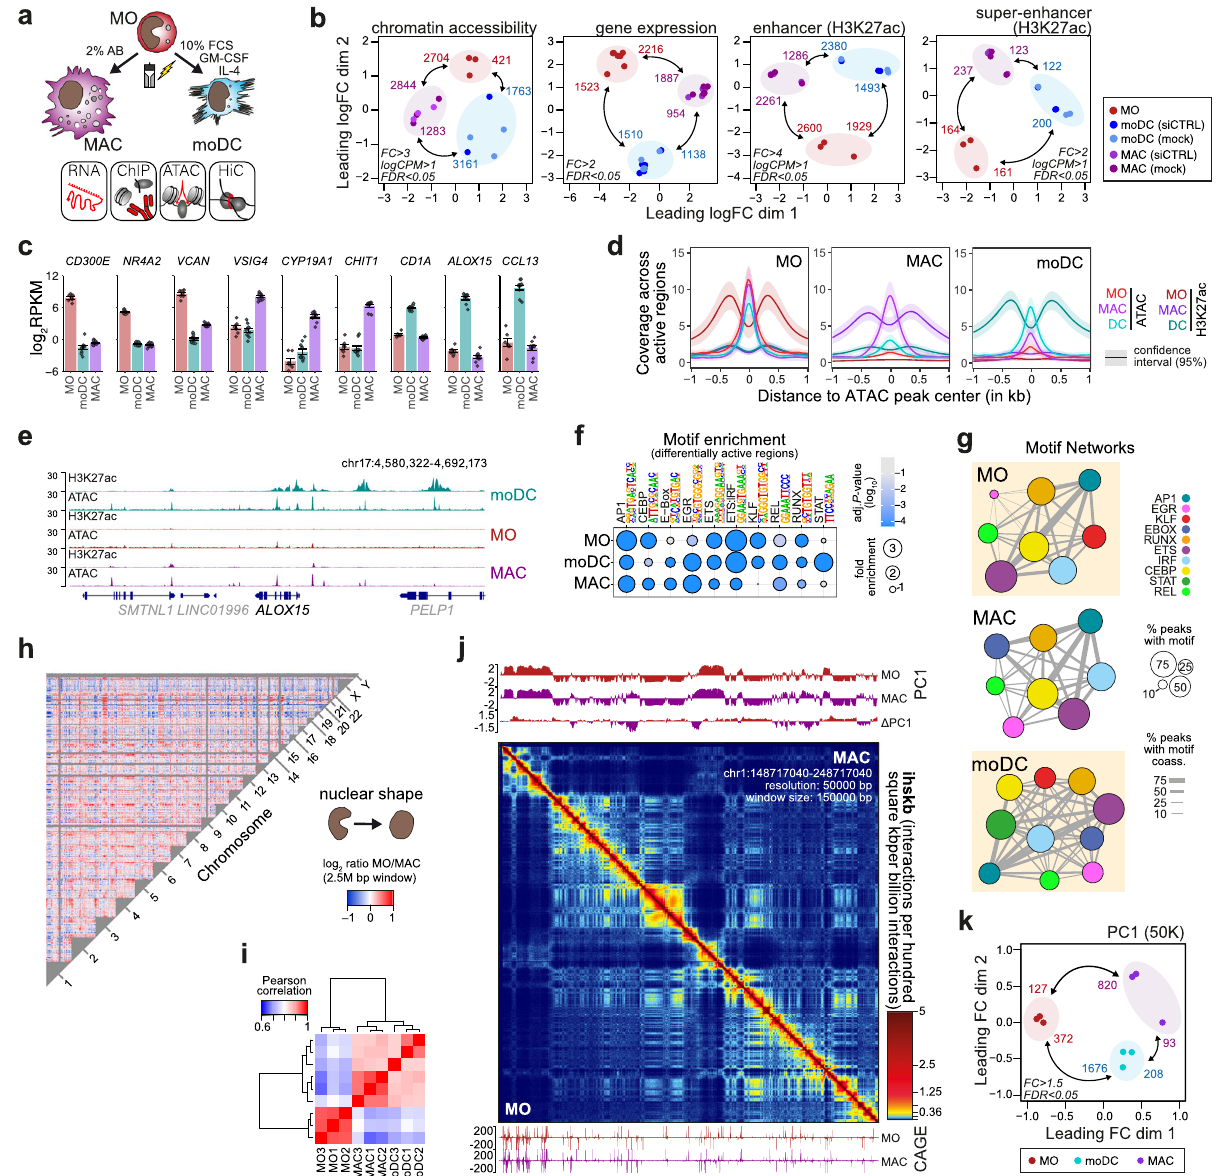
Fig. 1 Epigenetic, transcriptional and architectural changes during MO differentiation. a Schematic of the experimental setup. Since cells served as controls for the siRNA-mediated knockdown of structural proteins, MO were either mock-treated or electroporated with a control siRNA (siCTRL) after isolation and before culture. b Multidimensional Scaling (MDS) plots of ATAC-seq, RNA-seq, and H3K27ac ChIP-seq data sets. H3K27ac data are shown either on the levels of individual peak regions (enhancers) or arrays of peaks (super-enhancers). Numbers of differentially accessible sites, expressed genes, or H3K27ac de fi ned enhancers or super-enhancers are indicated. c Bar plots showing expression levels (mean normalized RPKM ± SE based on the RNA-seq data; n = 6 control samples from three donors) of typical cell type-associated genes. d Histograms of ChIP- and ATAC-seq coverage at differentially active regulatory regions (based on their H3K27ac deposition), centered on overlapping open chromatin. e Genome browser tracks for a moDC-speci fi c example region (additional examples in Supplementary Fig. 1d). f Motif enrichment (hypergeometric test, Benjamini-Hochberg (BH) corrected) across open chromatin regions shown in ( d ). g Motif co-association networks for regions given in ( d ). The size of each node represents the motif enrichment (fraction of peaks) and co-associated TF motifs are indicated by coloring. Edge thickness indicates the frequency of motif co-association. h Comparative interchromosomal contact map of MO and MAC. Coloring indicates the enrichment of contacts in MO (red) or MAC (blue) across 2.5 Mb windows. i Clustering of Pearson correlation values for all signi fi cant interchromosomal contacts between individual donors and cell types. j In situ Hi-C contact map of MO (lower left) and MAC (upper right) across a 50 Mb interval of chromosome 1. The map represents the average of 3 donor replicates per condition. Corresponding presentations for moDC are given in Supplementary Fig. 1l. Top, Tracks representing the fi rst eigenvector values (PC1) of a principal component analysis (PCA) on a Hi-C correlation matrix at 50kB resolution (PC1), including a difference track as indicated. Bottom, CAGE-seq data. k MDS plot of PC1 differences between cell types. Numbers of signi fi cantly different 50 K windows are indicated. ( c , f , g , i , k ) Source data are provided as a Source Data fi le.